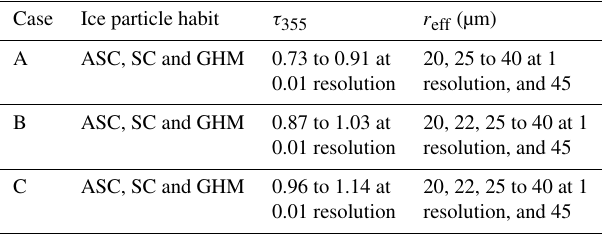
Table 2. Summary of the variation in the cloud bulk optical prop- erties for which radiance spectra were simulated for cases A, B and C. For each case, the cloud optical depth vertical profile was scaled according to the corresponding lidar extinction profile. The effec- tive radius of the ice particle size distribution were assumed to be constant for all layers within the cloud.